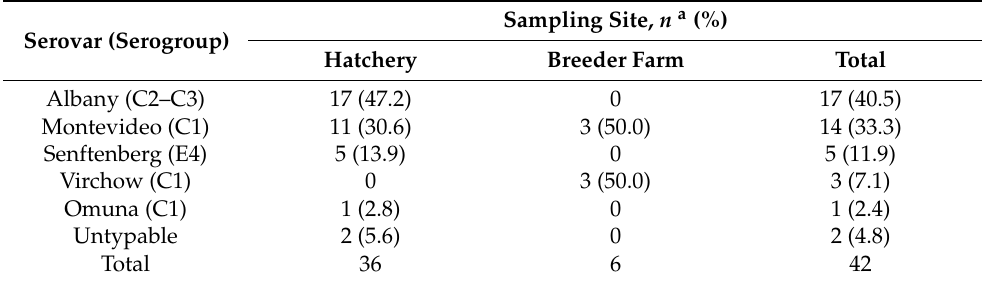
Table 1. Serotype distribution of Salmonella enterica in hatcheries and their upstream breeder farms. Serovar (Serogroup)